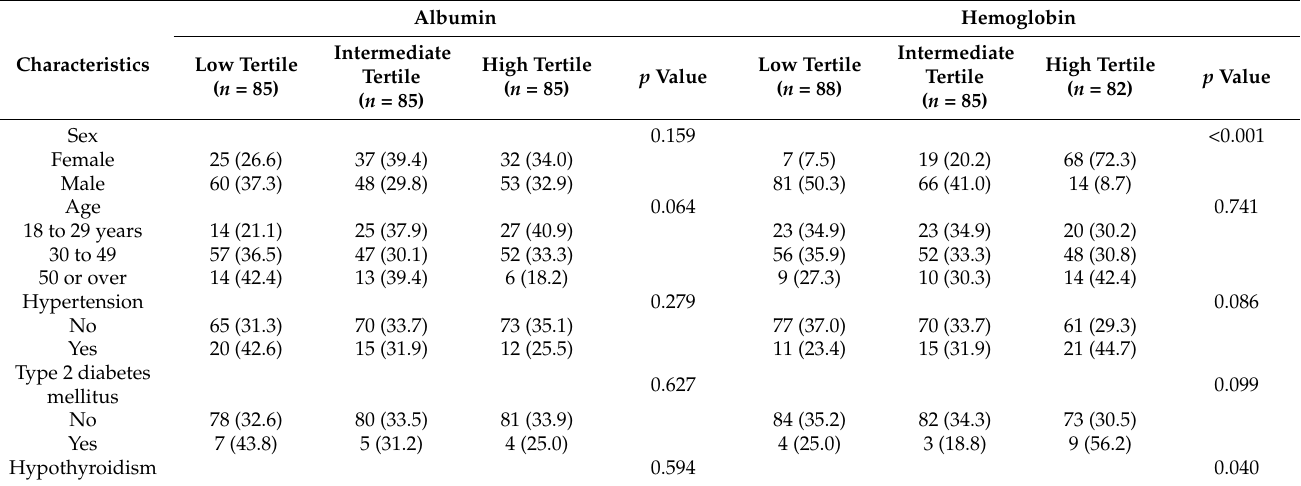
Table 3. Bivariate analysis of the demographic characteristics, medical history, laboratory and clinical markers, and outcomes of interest in the study